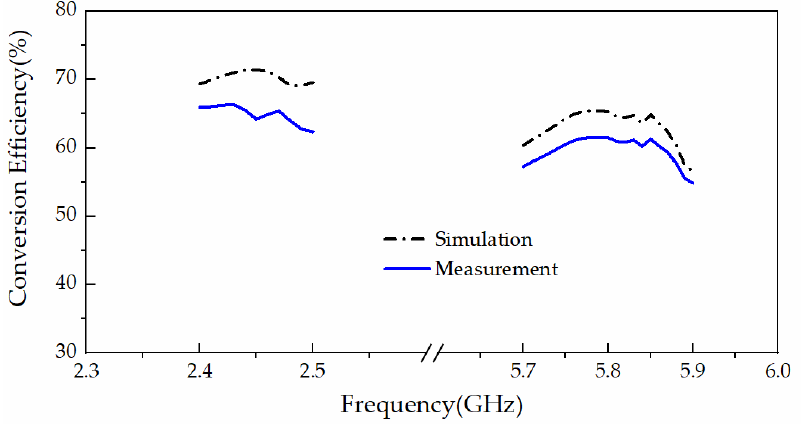
Figure 16. Simulated and measured conversion efficiency of the proposed dual ‐ band rectifier.